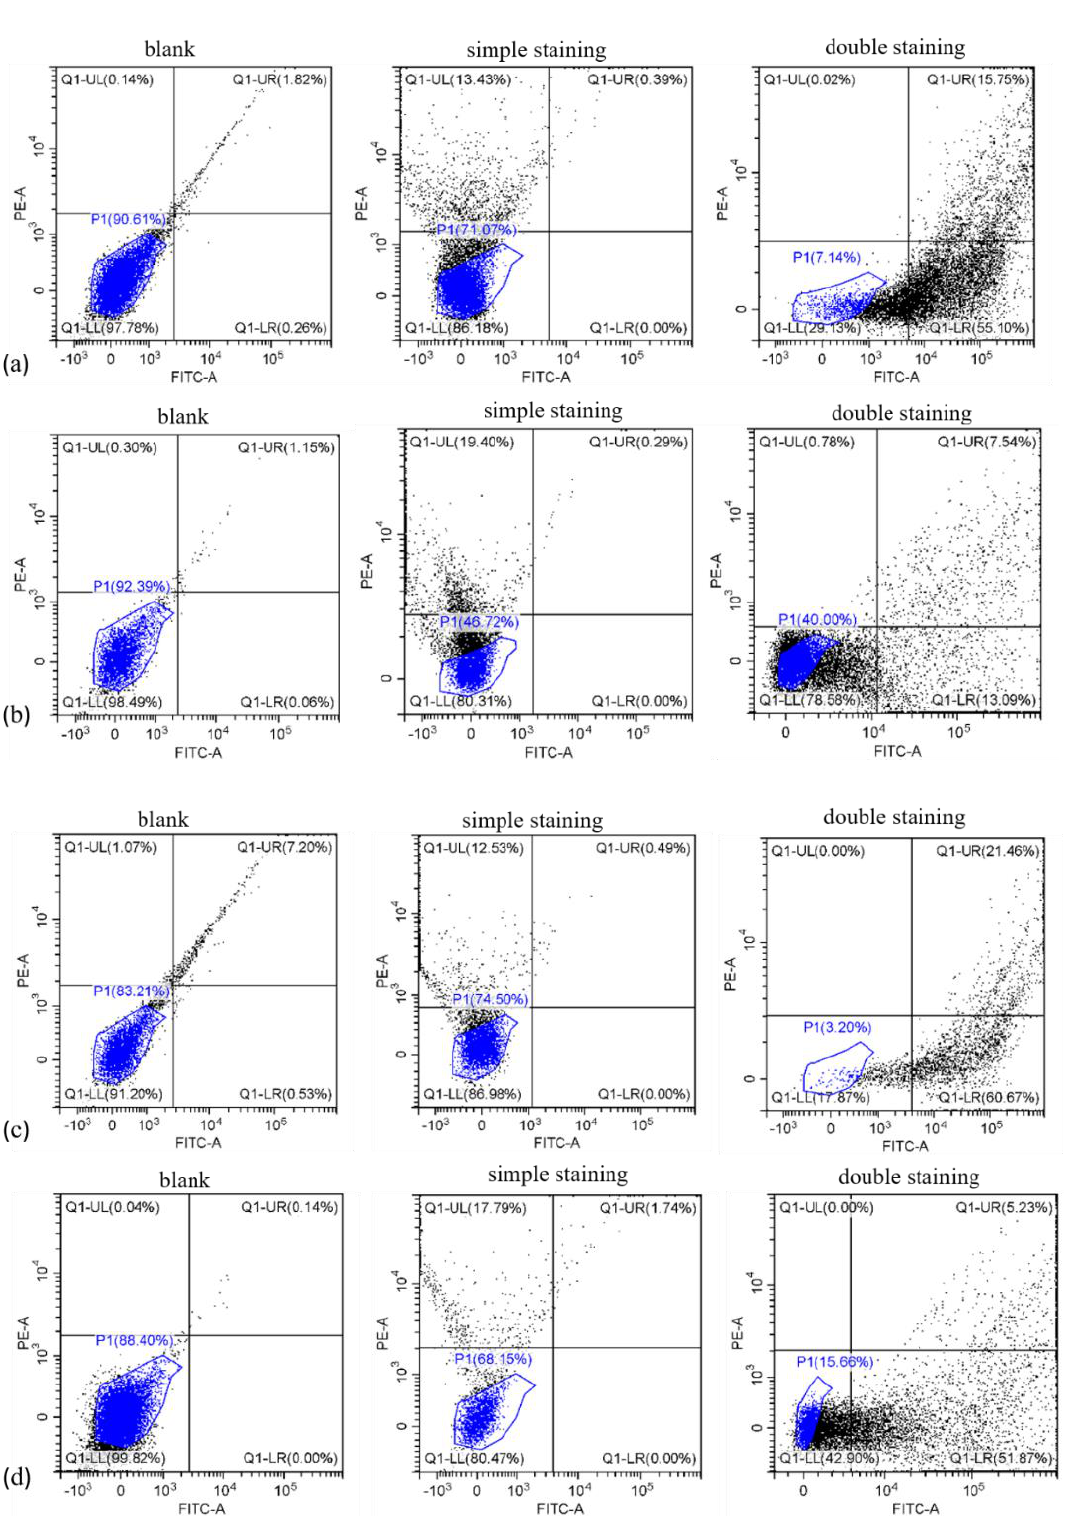
Figure 5. Cell apoptosis analysis for ( a ) ashore Canna indica , ( b ) offshore Canna indica , ( c ) ashore Acorus calamus , and ( d ) offshore Acorus calamus . Each of the sectors in the presented diagrams ( a − d ) stands for: PI positively and FITC negatively stained cells showing dead cells (upper left), FITC and PI double − stained cells showing late apoptosis (upper right), double − negative cells showing the live cell population (lower left), and FITC positively and PI negatively stained cells showing early apoptosis (lower right).